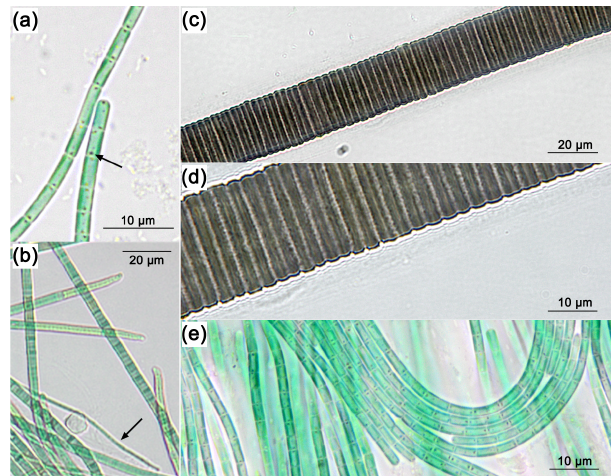
Figure 3. Light micrographs of the predominant isolates from sam- ple E4.1: (a) single filament of Persinema sp., arrow indicates aero- topes. (b) Biofilm of Klisinema sp. interspersed with Persinema sp. (arrow). (c) Lyngbya sp. filament. (d) Lyngbya sp. sheath detail. (e) Biofilm of Persinema